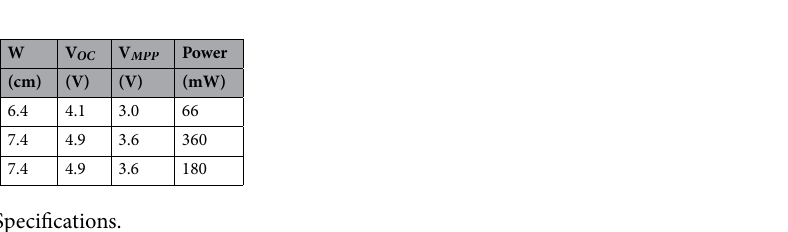
Figure 7. Power measurements from sleeve during different scenarios. The mannequin arm positioned ( a ) down and straight, ( b ) up and straight, ( c ) down and bent, and ( d ) up and bent. ( e ) The average output power over 30 seconds for three trials and ( f ) corresponding efficiency obtained using the five-panel sleeve and converter system during each scenario.